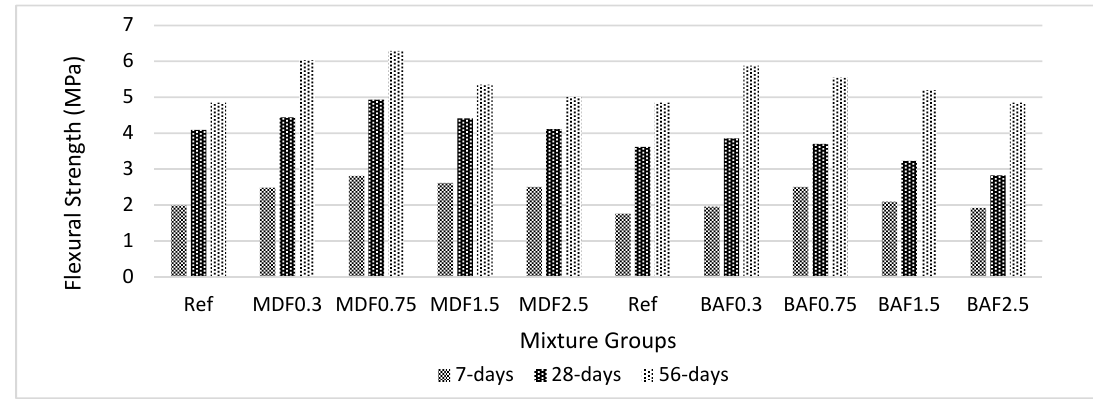
Figure 9. Effect of carbon fiber on flexural strength for marble dust and bottom ash mixture groups at 7, 28, and 56 days of curing.